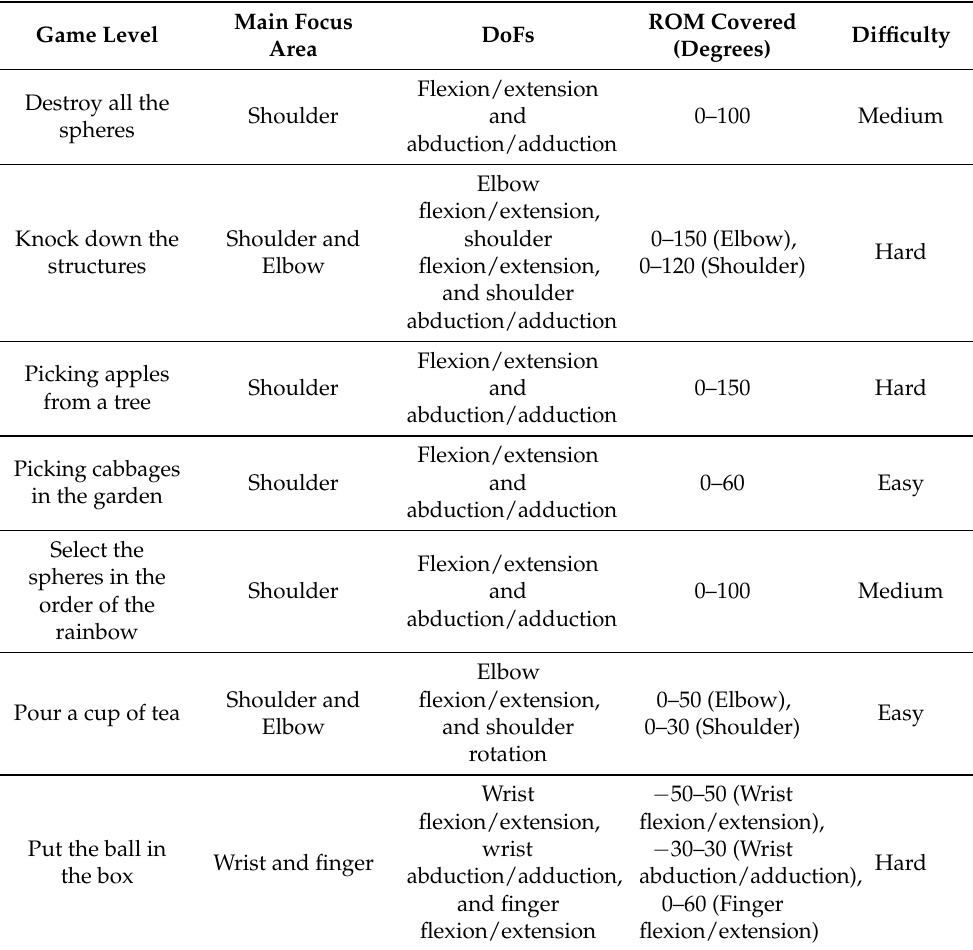
Figure 2. Different game levels. ( a ) A level where the user selects all the spheres in order to “destroy” them. ( b ) A level where the user knocks down structures with blue spheres. ( c ) Picking apples from a tree. ( d ) A level where the user must put a ball in a box. ( e ) Picking cabbages in the garden. ( f ) Pouring a cup of tea. Table 1. Game level difficulties based on the DoFs and